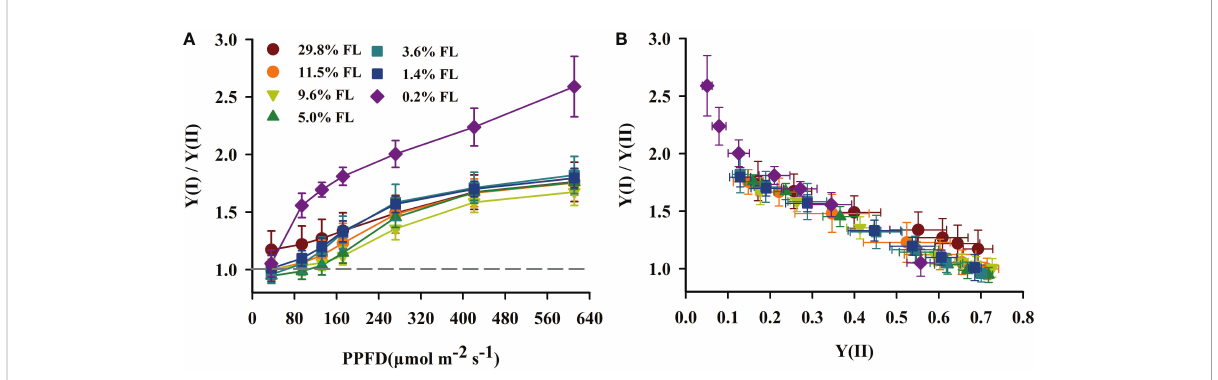
FIGURE 7 The effect of light regimes on cyclic electro transport in P. notoginseng . (A) Light response changes in Y(I)/Y(II) for leaves of P. notoginseng grown under different light regimes. Above the gray line represents the start of cyclic electron transport being excited. (B) Relation between Y(I)/Y(II) and Y (II) (line electro transport) for leaves of P. notoginseng grown under different light regimes. Values for each point were means ± SD ( n =